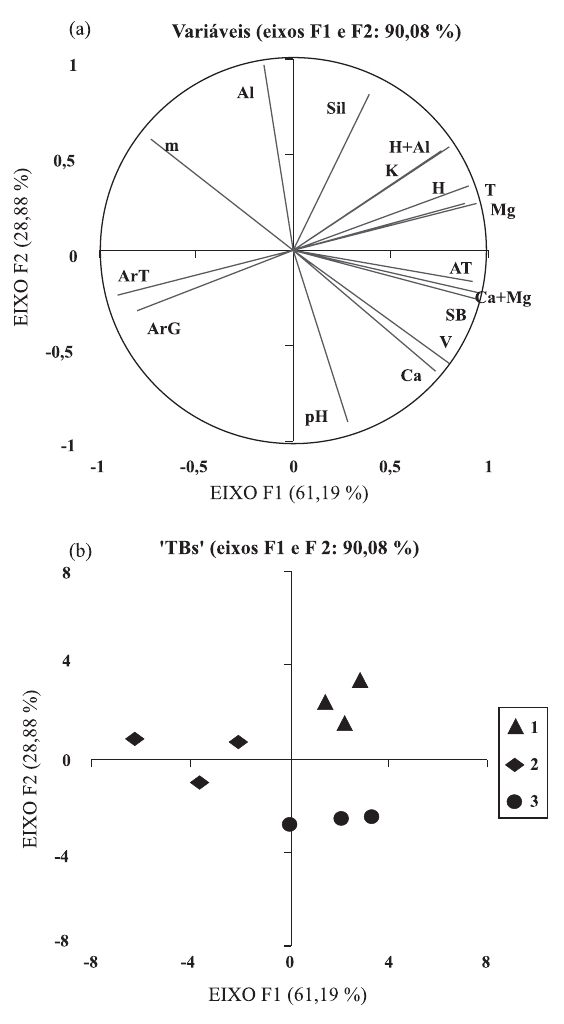
1. Agrupamento das terras (TB1, TB2 e TB3) em função dos atributos do solo representativos, pela análise de componentes principais, na profundidade de 0-0,05 m. (a) atributos do solo e (b) agrupamento das yvy porá